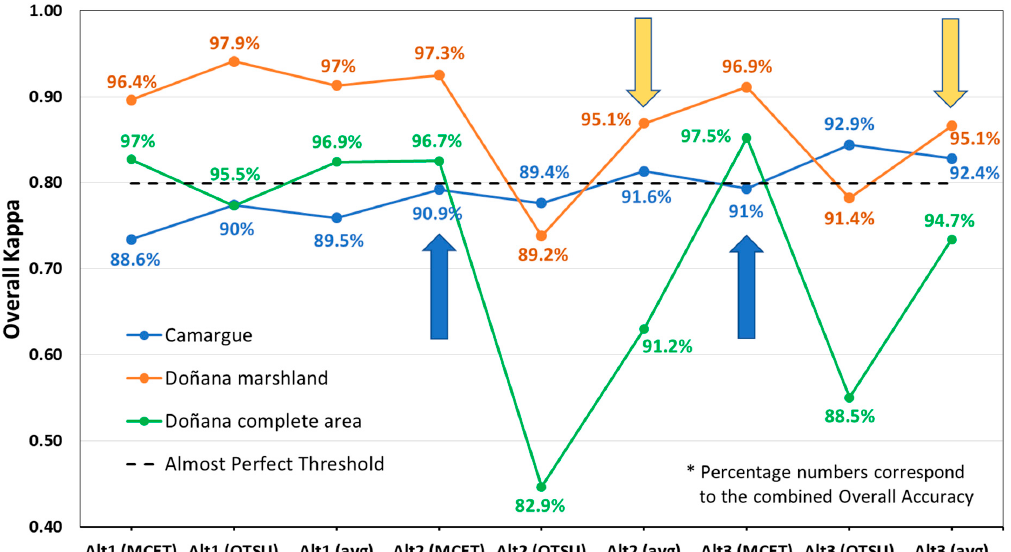
Figure 10. Overall Kappa per approach and examined study area. The dotted line delineates the threshold of the “Alm Perf” case. Yellow arrows indicate alternative approaches succeeding “Alm Perf” results in Camargue and Doñana marshland at the same time, while blue arrows showcase the most successful overall alternative ones. The combined overall accuracy of each approach per study area is given as a number close the point corresponding to its overall Kappa.